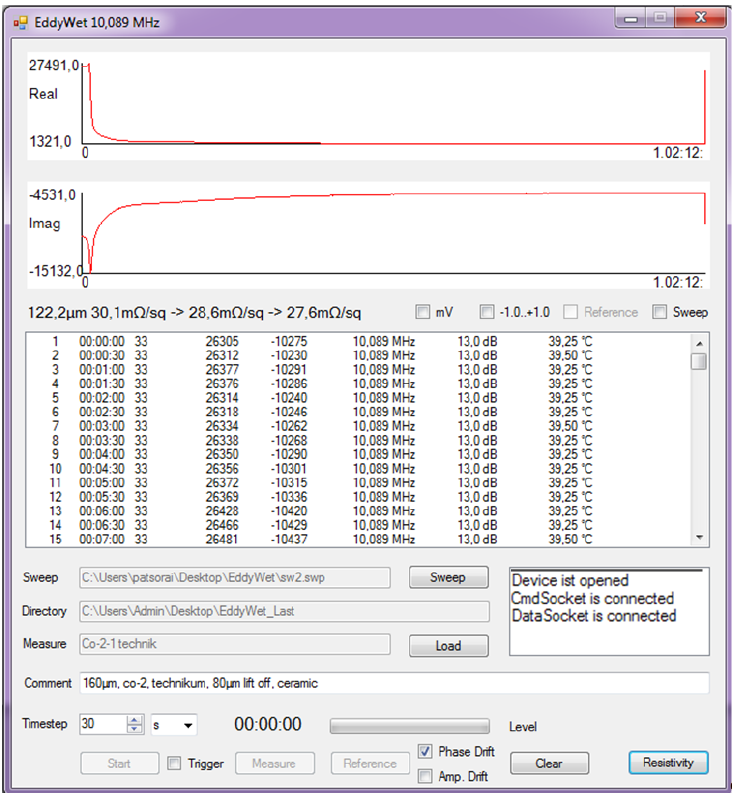
Figure 17. Screenshot of the “Eddy Wet” Main Menu.